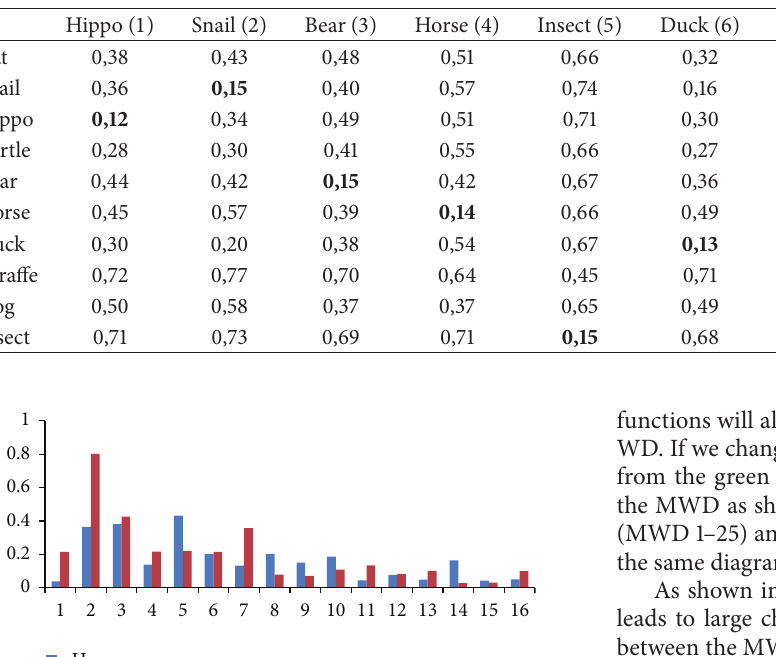
Figure 16: The MWD of the shape “Giraffe” with and without artificial noises. Table 2: The Euclidean distance matrix of FD.